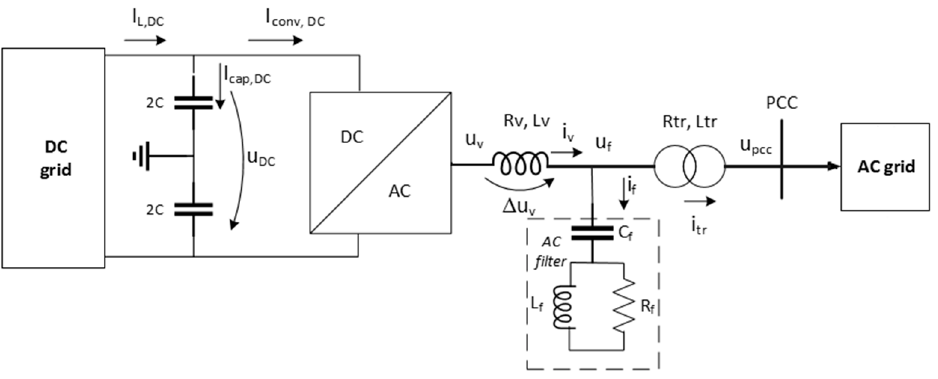
Figure 1. Representation of a VSC (adapted from [5]). Reproduced from [X], the name of the pub- lisher: 201X.